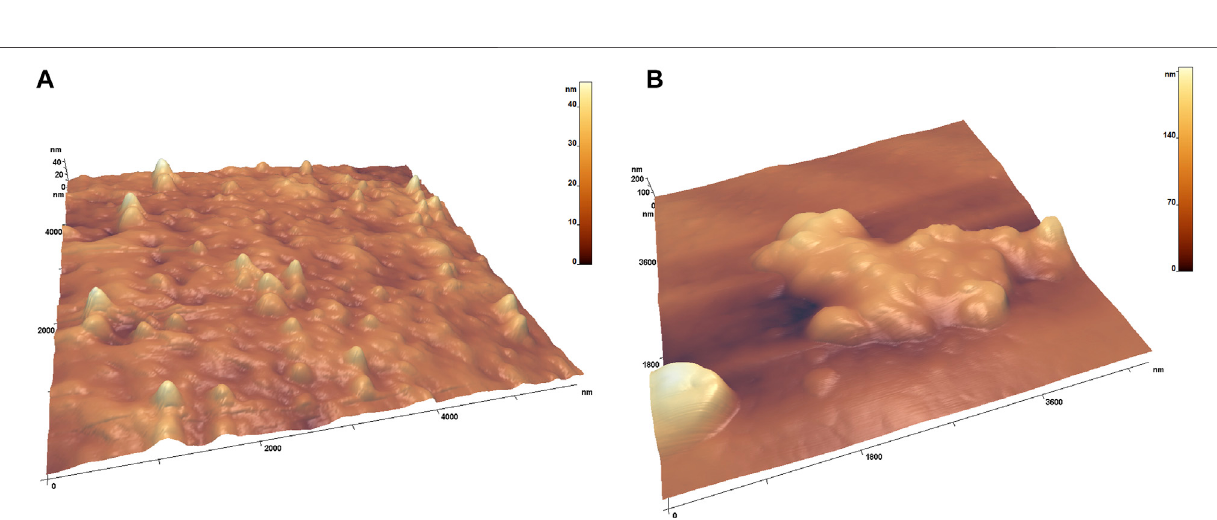
FIGURE 8 | Scanning electron microscopy images of the polyethylene terephthalate membrane with a pore size of 320 nm. (A) Front view; (B) side view.